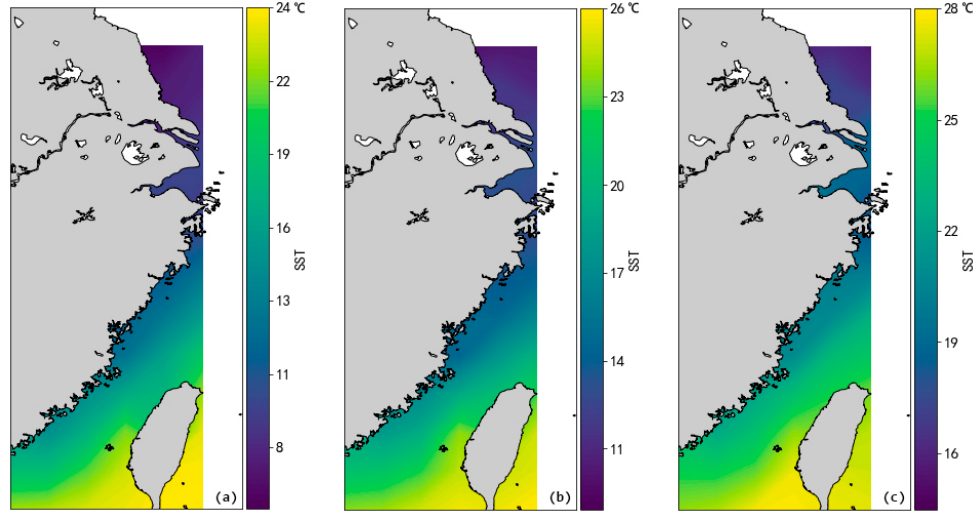
Figure 5. Average temperature in March, April, and May before assimilation. ( a ) Average temperature in March. ( b ) Average temperature in April. ( c ) Average temperature in May.